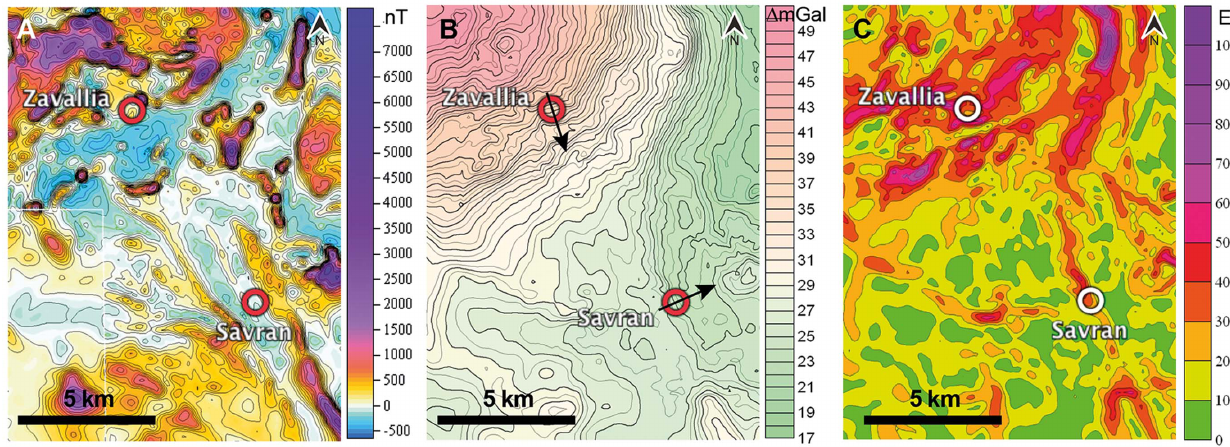
Figure 1. Magnetic and gravity anomalies around the pigeon lofts. The location of the pigeon lofts, Zavallia and Savran, are indicated with a circle. (A) Magnetic anomaly map (nT=nanoTesla). (B) Gravimetric anomalies, the change of the gravity intensity ( D G B – Bouguer, mGal=milligal). Arrows show the direction of the gravity gradients. (C) Horizontal gravity gradients (E=Eo¨tvo¨s), highest values mark locations with steepest gradient of gravimetric values in border zones of gravimetric anomalies. Note the location of the Savran loft (S-pigeons) on a small yet steep gravity gradient in east-west direction characterized by elevated E-values. For a photographic map illustrating the topography of the area see https://www.dropbox. com/sh/2yrhdtcyzt5uu99/ZFJeNJb0lk.